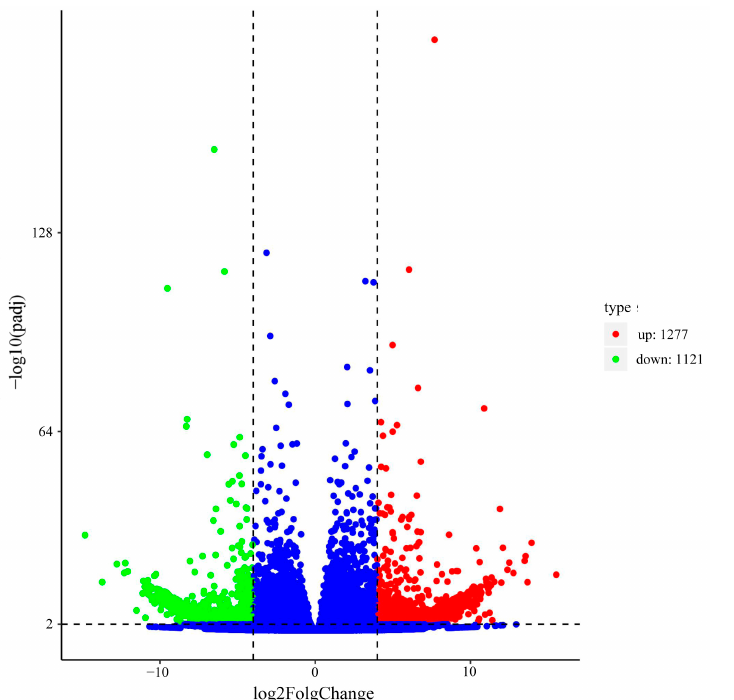
Figure 4. The volcano plot of differentially expressed genes (DEGs) in B. striata leaves under CK and drought conditions. Red plots represent upregulated DEGs, green plots represent downregulated DEGs, and blue plots represent the DEGs without significantly change.